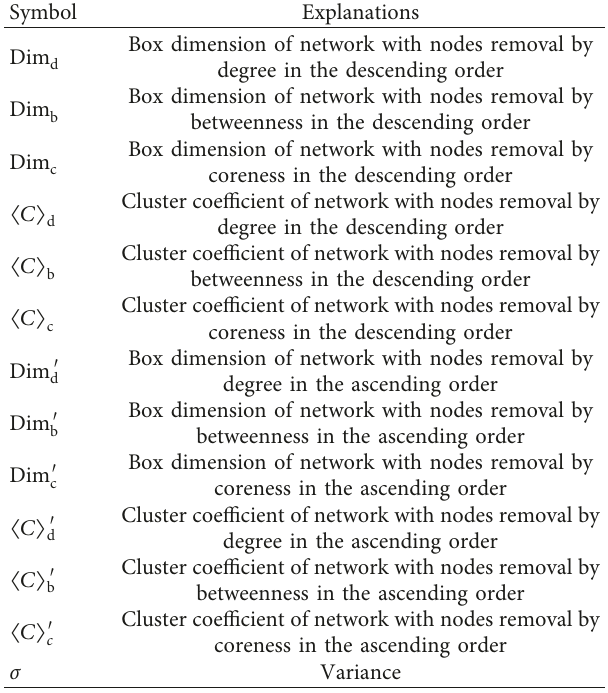
Table 1: Some symbolic